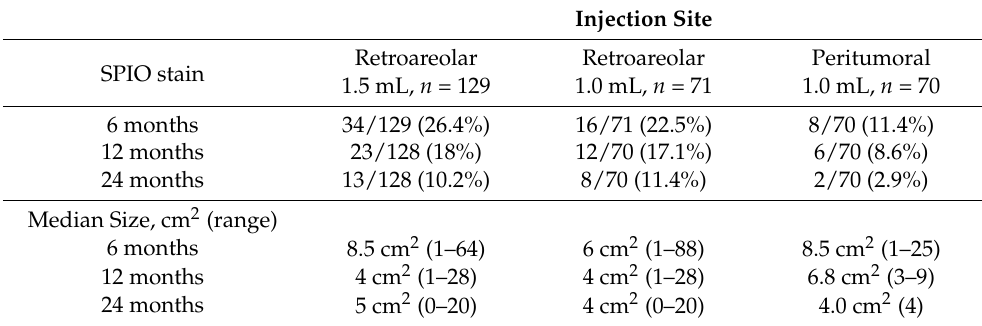
Table 3. Incidence and median size of SPIO staining postoperatively by injection site and volume.